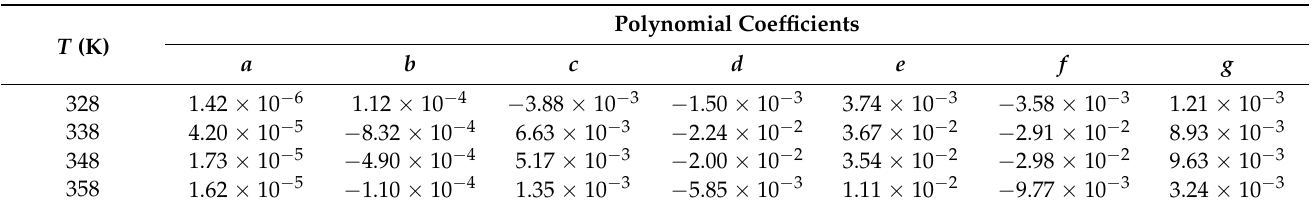
(cid:0) (cid:1) C w for each drying temperature.